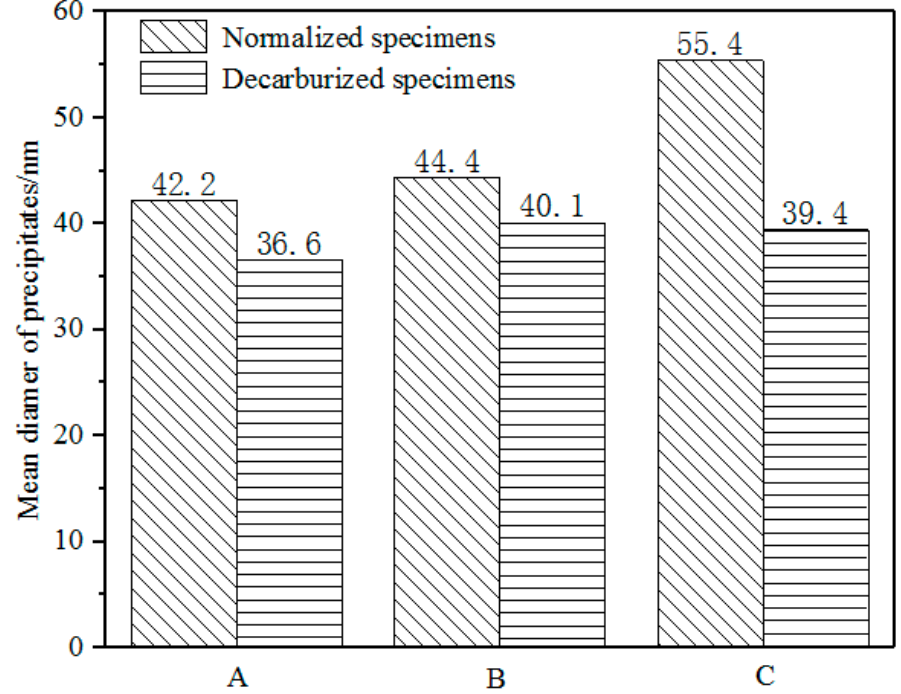
Figure 5. Mean size of the precipitates in the normalized and decarburized specimens.